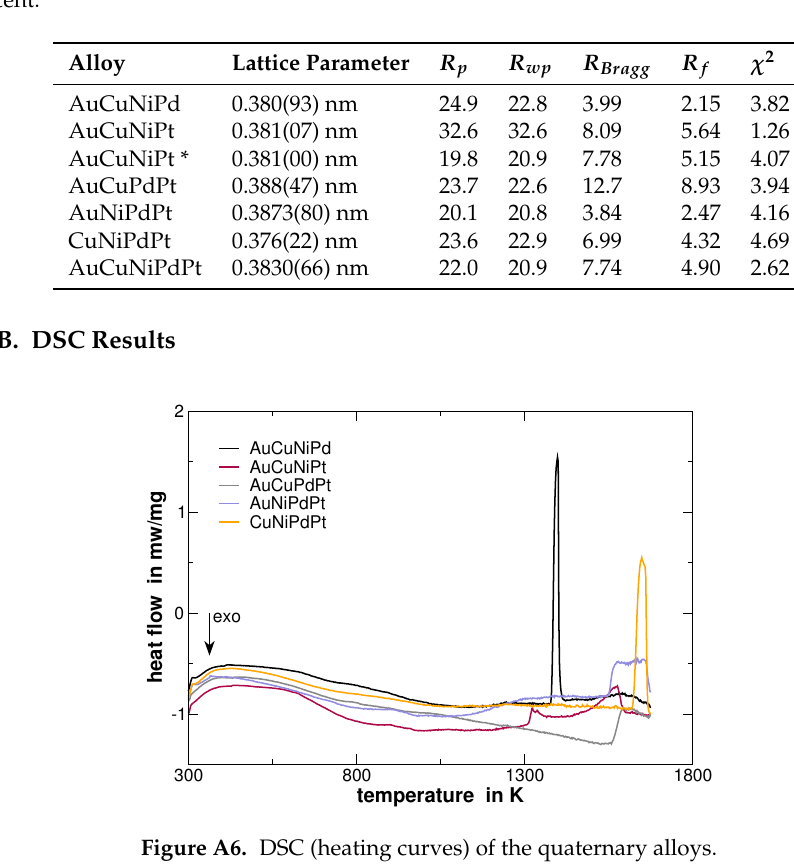
Figure A5. Experimental (points) and calculated (solid line) XRD patterns as well as their difference ∆ I (lower part) and Bragg positions (vertical lines) of homogenized AuCuNiPdPt. Table A1. Lattice parameters and reliability factors for points with Bragg contributions. Conventional Rietveld R-factors are given using background-corrected counts. Furthermore, the Bragg R-factor and the RF-factor are provided. Values are provided for the homogenized state with the exception of AuCuNiPt *, where the values for the segregated state is given. The R-factors are too large, because the line shape caused by the segregations cannot be described properly. Values for the R-factors are given in per cent.